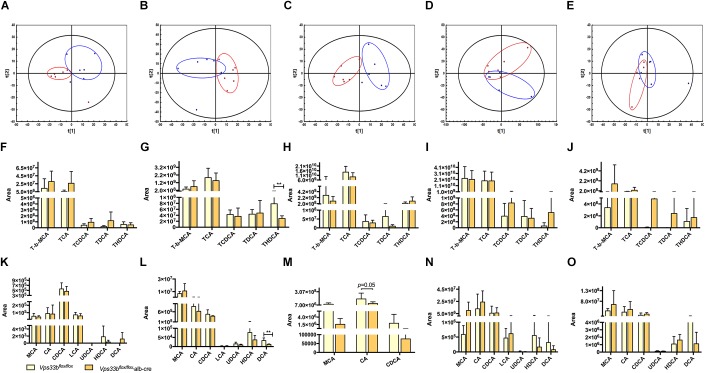
Principal component analysis (PCA) score plot (A–E) of Vps33bflox/flox mice (Blue) and Vps33bflox/flox, alb-cre mice (Red). ESI-negative mode; Serum (A); Liver (B), Bile (C); Intestine (D) and Feces (E). Bile acid components in serum (F,K), liver (G,L), bile (H,M), intestine (I,N) and feces (J,O) of mice. Conjugated bile acids (F–J); Unconjugated bile acids (K–O).